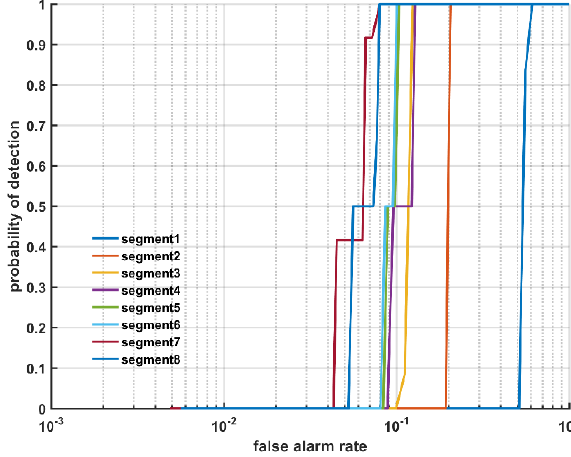
Figure 7 The ROC curves of our method with different segmentation